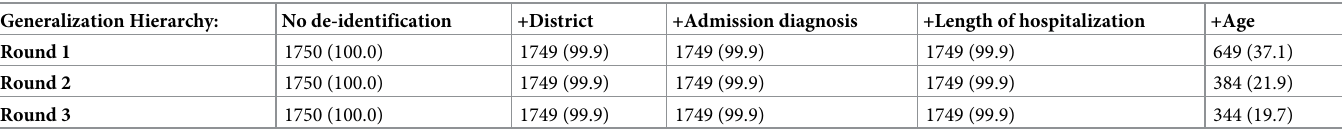
Table 6. K-anonymity violations at compounding steps of generalization in order of increasing variable importance for the three hierarchical rounds, N (%). Generalization